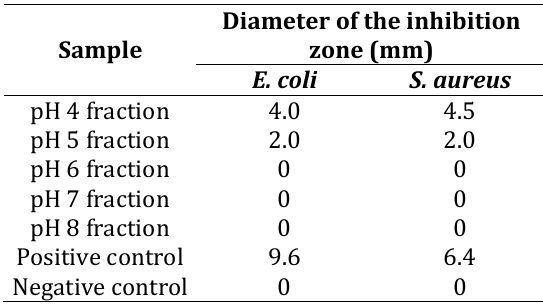
Figure 1. Growth inhibition zones of the pH 4 and pH 5 fractions of R. communis seed protein hydrolysate for E.coli (a) and S. aureus (b). Amoxicillin and distilled water are used as positive control (+) and negative control (−), respectively, and each fraction was replicated (1 and 2) Table I. Inhibition zones of the peptide fractions of R. communis seed protein hydrolysate for E.coli and S.